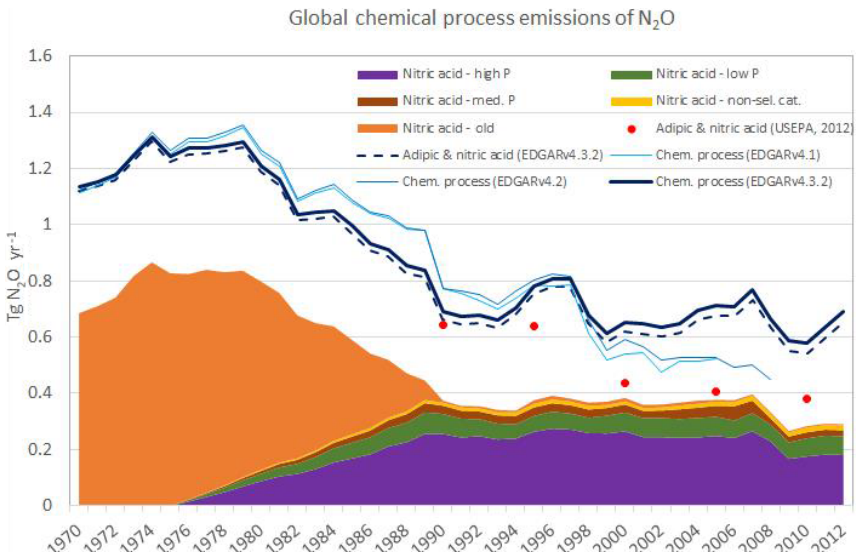
Figure 8. Global N 2 O emissions trends for chemical processes, which mainly originate from nitric and adipic acid production (apart from smaller contributions from glyoxal and caprolactam production). The coloured area illustrates the penetration of technology for nitric acid production (with high-pressure plants, medium-pressure plants, low-pressure plants, plants with non-selective catalytic reduction and old plants) to reduce the emissions.